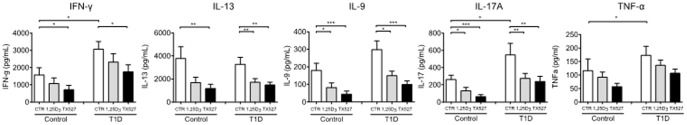
1,25(OH)2D3 and TX527 reduce T helper cytokines in human T cell cultures.Human peripheral blood CD3+ T cells, isolated from control subjects (n = 19) and type 1 diabetes patients (n = 20), were activated using anti-CD3/CD28 and treated with vehicle (CTR), 10−8 M 1,25(OH)2D3 (1,25D3) or 10−8 M TX527. Concentrations of indicated cytokines were determined in the supernatant of day 8 cultures. Results are shown as bar graphs of mean ± SEM, data are grouped per treatment and donor type. Significance was calculated using a two-tailed Mann-Whitney test. * P<0.05; ** P<0.01; *** P<0.001. All other comparisons were not statistically significant.